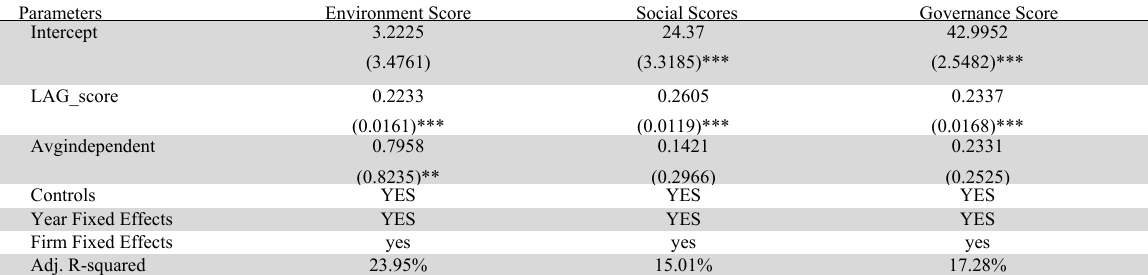
Panel C: Average Directorships by Independent Directors (directorshipsIND) n = 550 Dependent